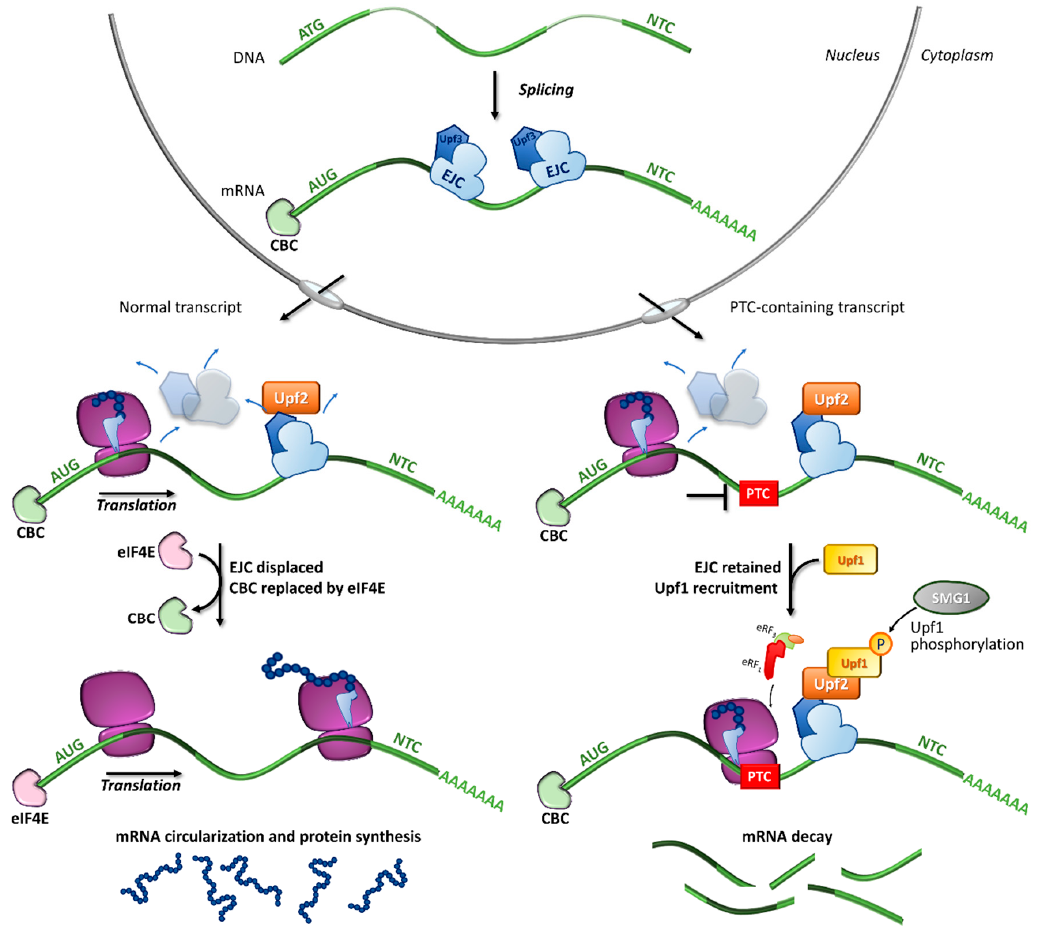
Figure 2. Fates of normal or PTC-bearing mRNA transcripts during the first step of translation. The splicing of pre-mRNA into the nucleus results in a mature mRNA transcript bound to exon-junction complexes (EJCs) as well as other key components such as the Upf3 (in the nucleus) and Upf2 (in the cytoplasm) proteins. Once transported into the cytoplasm, the mRNA undergoes a first (pioneer) round of translation. In normal conditions, the ribosome displaces all EJCs, resulting in the replacement of CBC with eIF4E, mRNA circularization and protein synthesis, which proceeds until the natural termination codon (NTC) is reached. If a premature termination codon (PTC) is present, EJCs are not efficiently removed by the ribosome, resulting in recruitment of eRF 1 , eRF 3 , Upf1 and the SMG1 kinase, which leads to Upf1 phosphorylation and degradation of the UPF1-tagged mRNA.